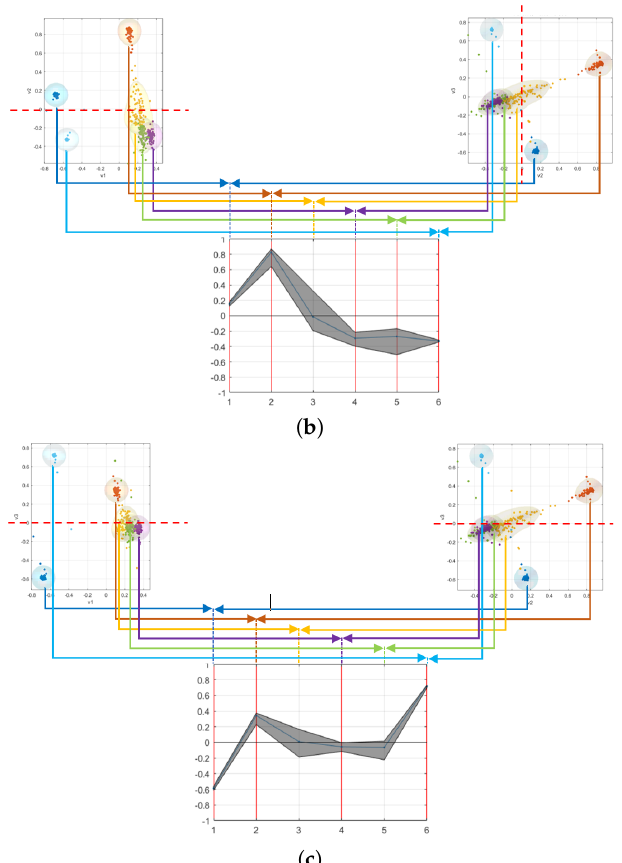
Figure 6. Fire-brigade categories and relation between paired projected categories plots and their eigenvectors: ( a ) Detail on eigenvector v 1, and projected categories in terms of v 1 and v 2 (left), and of v 1 and v 3 (right); ( b ) Detail on eigenvector v 2, and projected categories in terms of v 1 and v 2 (left) and v 2 and v 3 (right); ( c ) Detail on eigenvector v 3, and projected categories in terms of v 1 and v 3 (left) and of v 2 and v 3